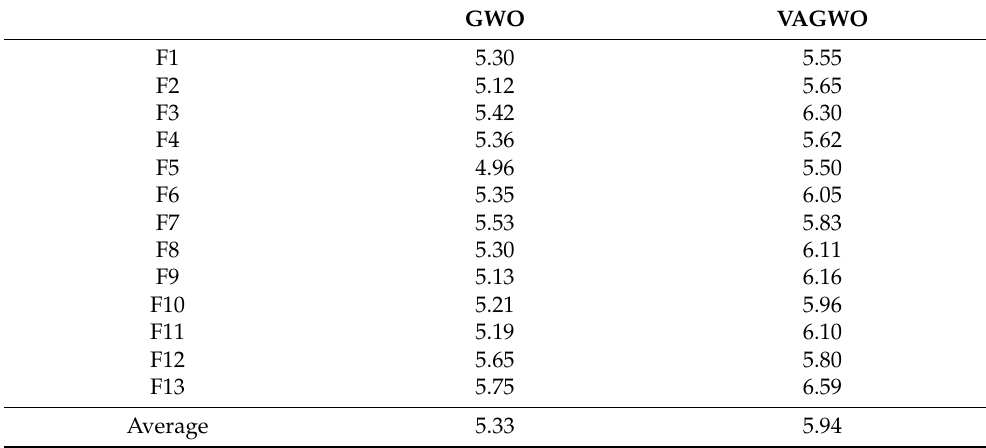
Table 15. The independent runtime of VAGWO against GWO on the CEC2017 composition functions (seconds).